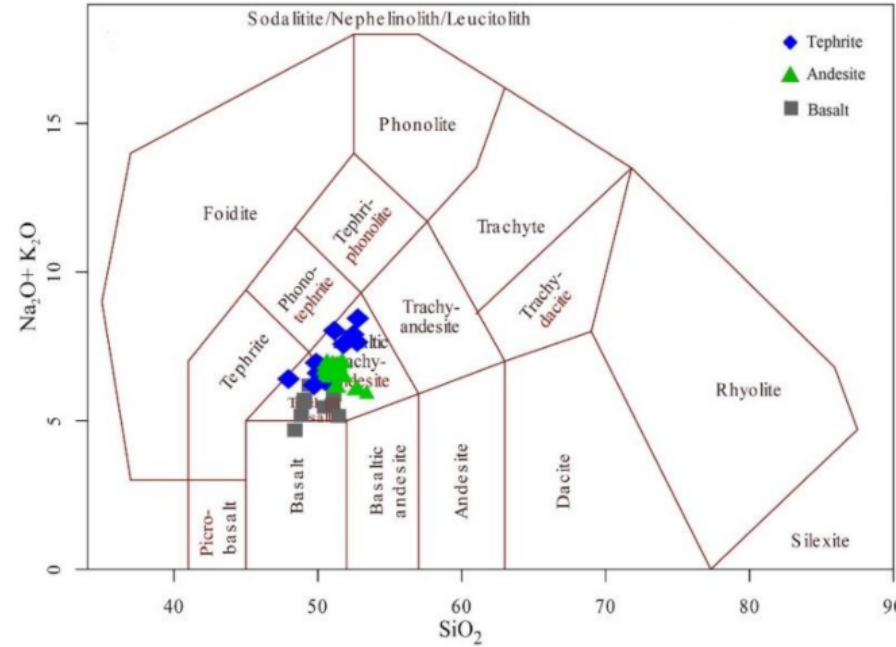
Figure 5. Total alkali versus silica (TAS) classification diagram